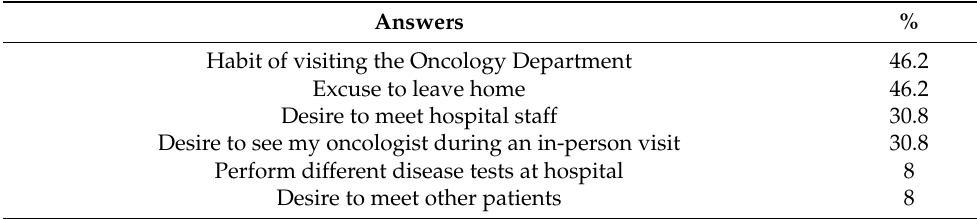
Table 3. Main reasons for declining the Home Se-Cure